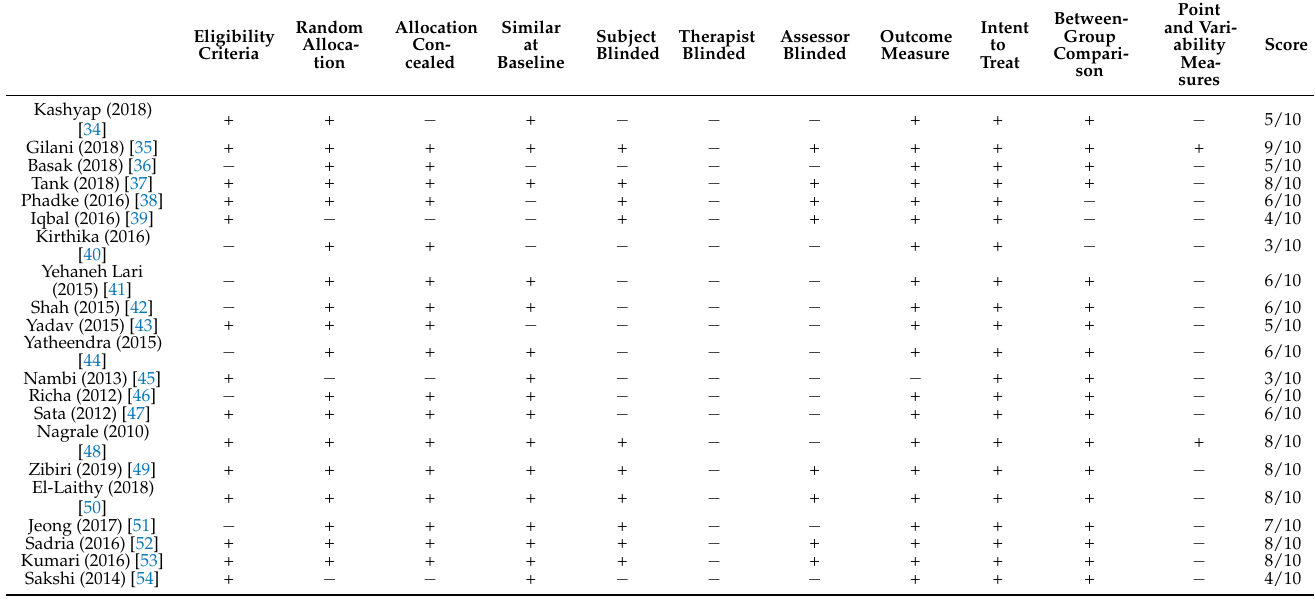
Table 4. Pedro score